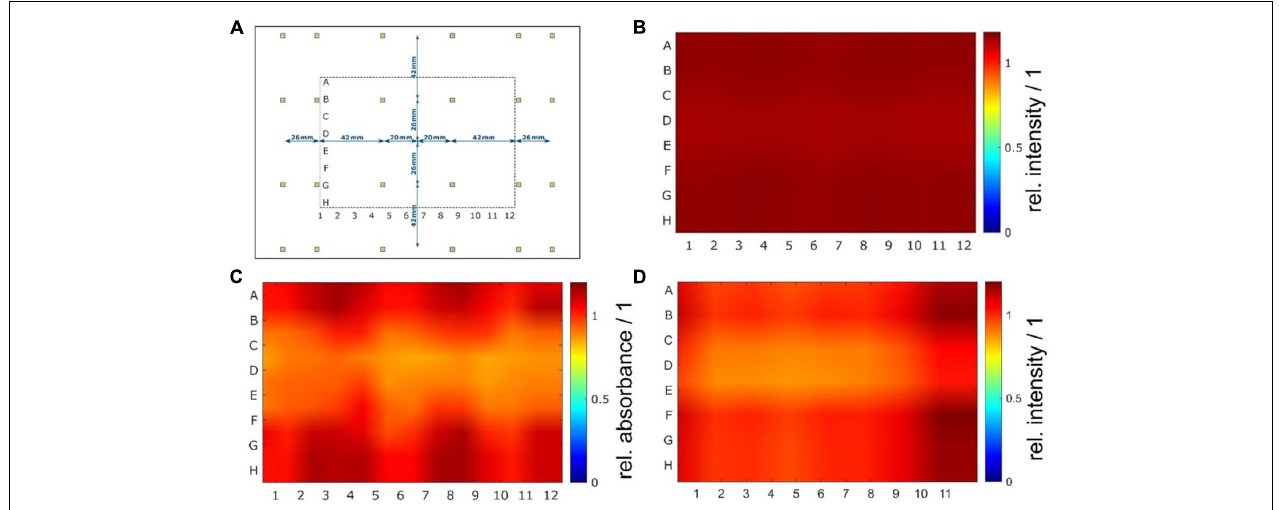
FIGURE 3 | (Color online) Non-equidistant LED arrangement and results of homogeneity measurements. A nonlinear optimization of the individual LED positions in the xy -plane of the printed circuit board resulted in a symmetric but not equidistant arrangement with decreasing distances on the outside. For a better understanding of the LED arrangement, the position of the irradiated plate is illustrated as well (A) . The irradiance distribution at the sample plane was determined by optical simulations (B) and measured with a chemical actinometer (C) and a radiometer (D) . In the optical simulations, a very high uniformity with a theoretical coefficient of variation of less than 0.1% ( cv sim = 0 . 08% ) was calculated. Experimental evaluation of the uniformity resulted in variations of less than 10% (chemical actinometer cv act = 9% and radiometer cv rad =